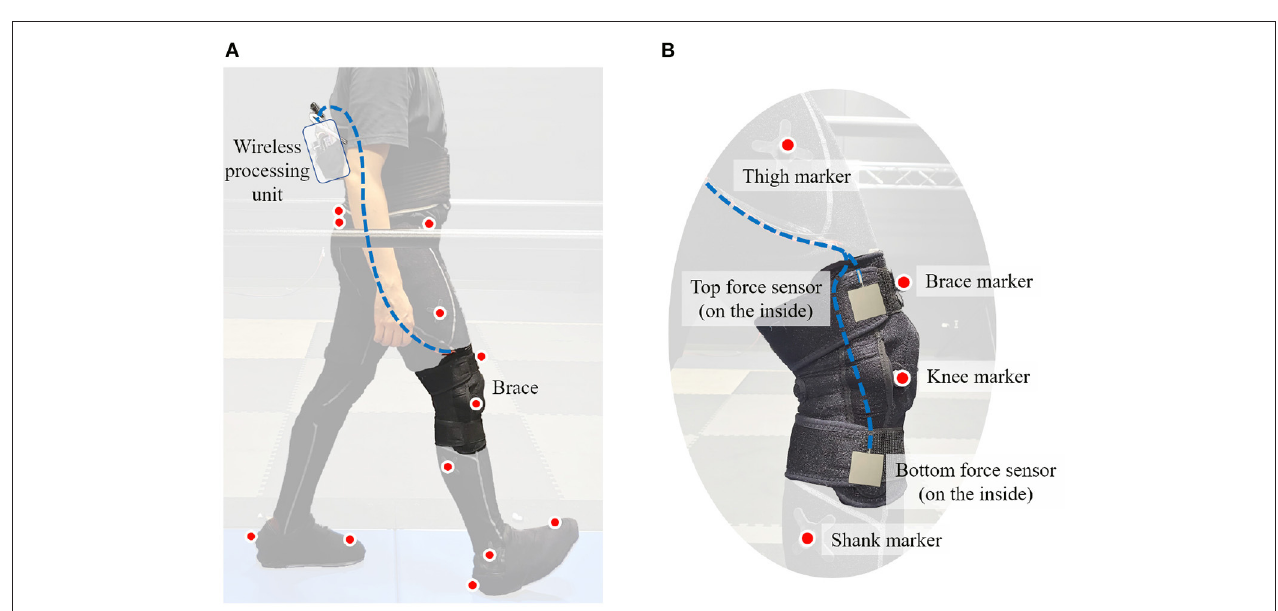
FIGURE 3 | Experiment setup: (A) Subject with markers and a brace, (B) markers and sensors mounted on the brace.